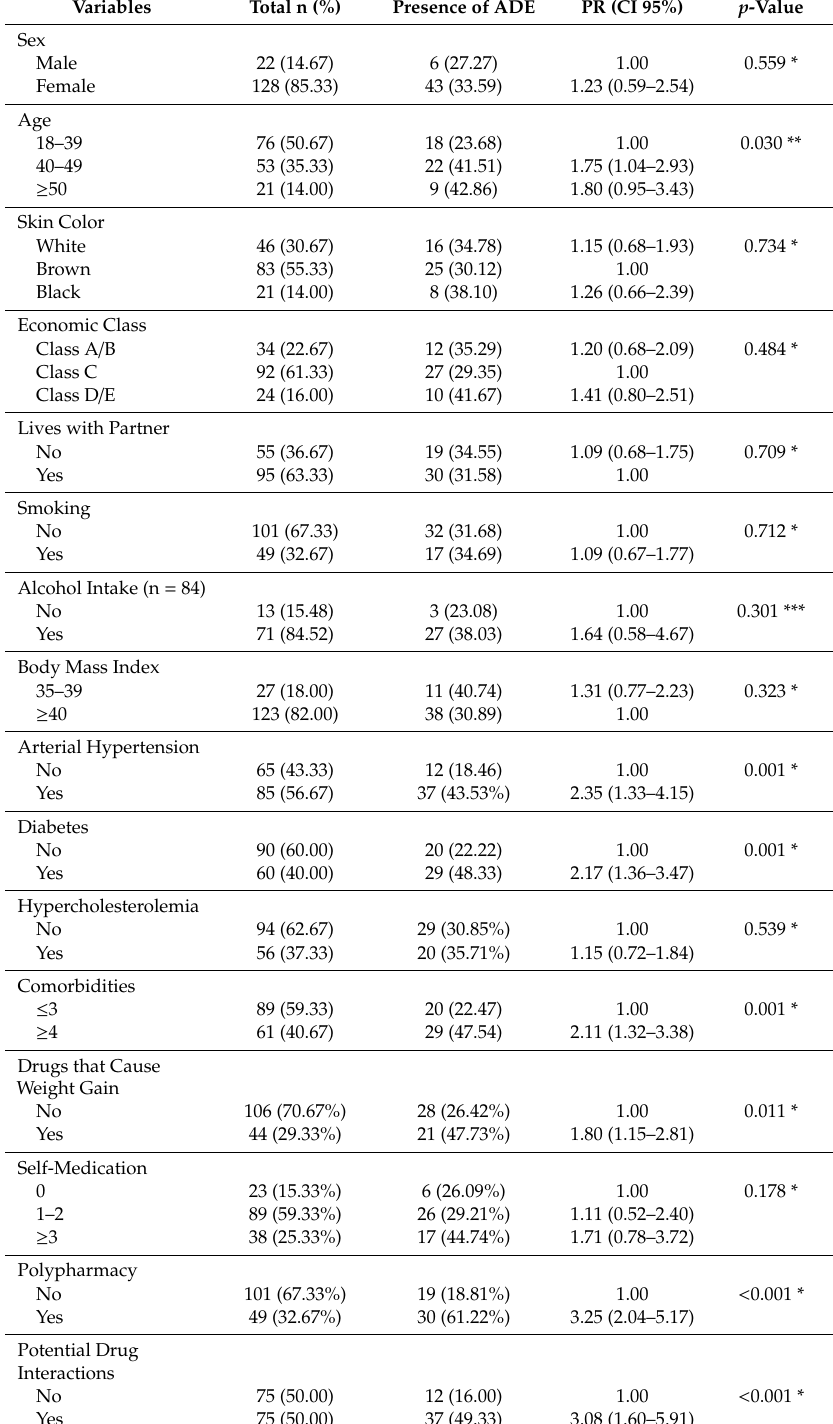
Table 3. Frequency of adverse drug events and their association with sociodemographic variables, lifestyle, health profile, and drug use in severely obese adults ( n =